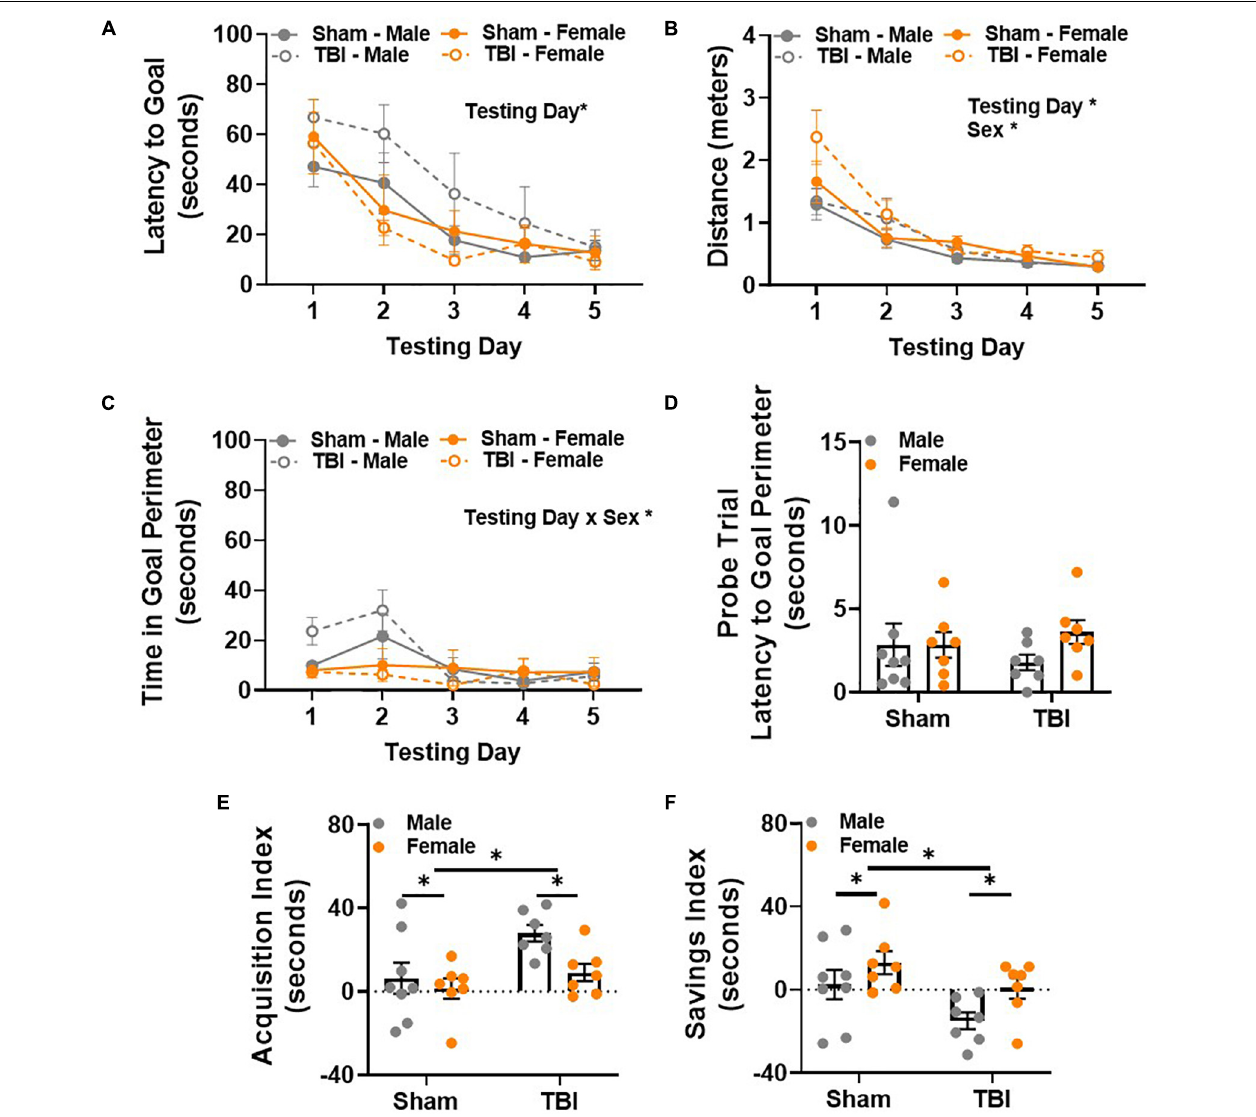
FIGURE 4 | Male TBI mice display unique spatial memory deficits 14 weeks post-injury characterized by impaired transfer of information between testing days. (A) Latency to reach the Barnes maze goal box decreases over testing days. (B) Distance to reach the Barnes maze goal box decreases over testing days. (C) Male TBI mice spend more time in the goal perimeter during the first 2 days of testing, but this resolves over time. (D) Latency to the goal perimeter did not differ between experimental groups during the probe trial. (E) Average acquisition index shows that latency to reach the goal box significantly decreases in male TBI mice compared to all other groups. (F) Average savings index shows that latency to reach the goal box significantly increases in male TBI mice compared to all other groups. N = 7–8/group; error bars indicate SEM. Main effects are identified in the figure, unless an interaction effect was identified. ∗ p <